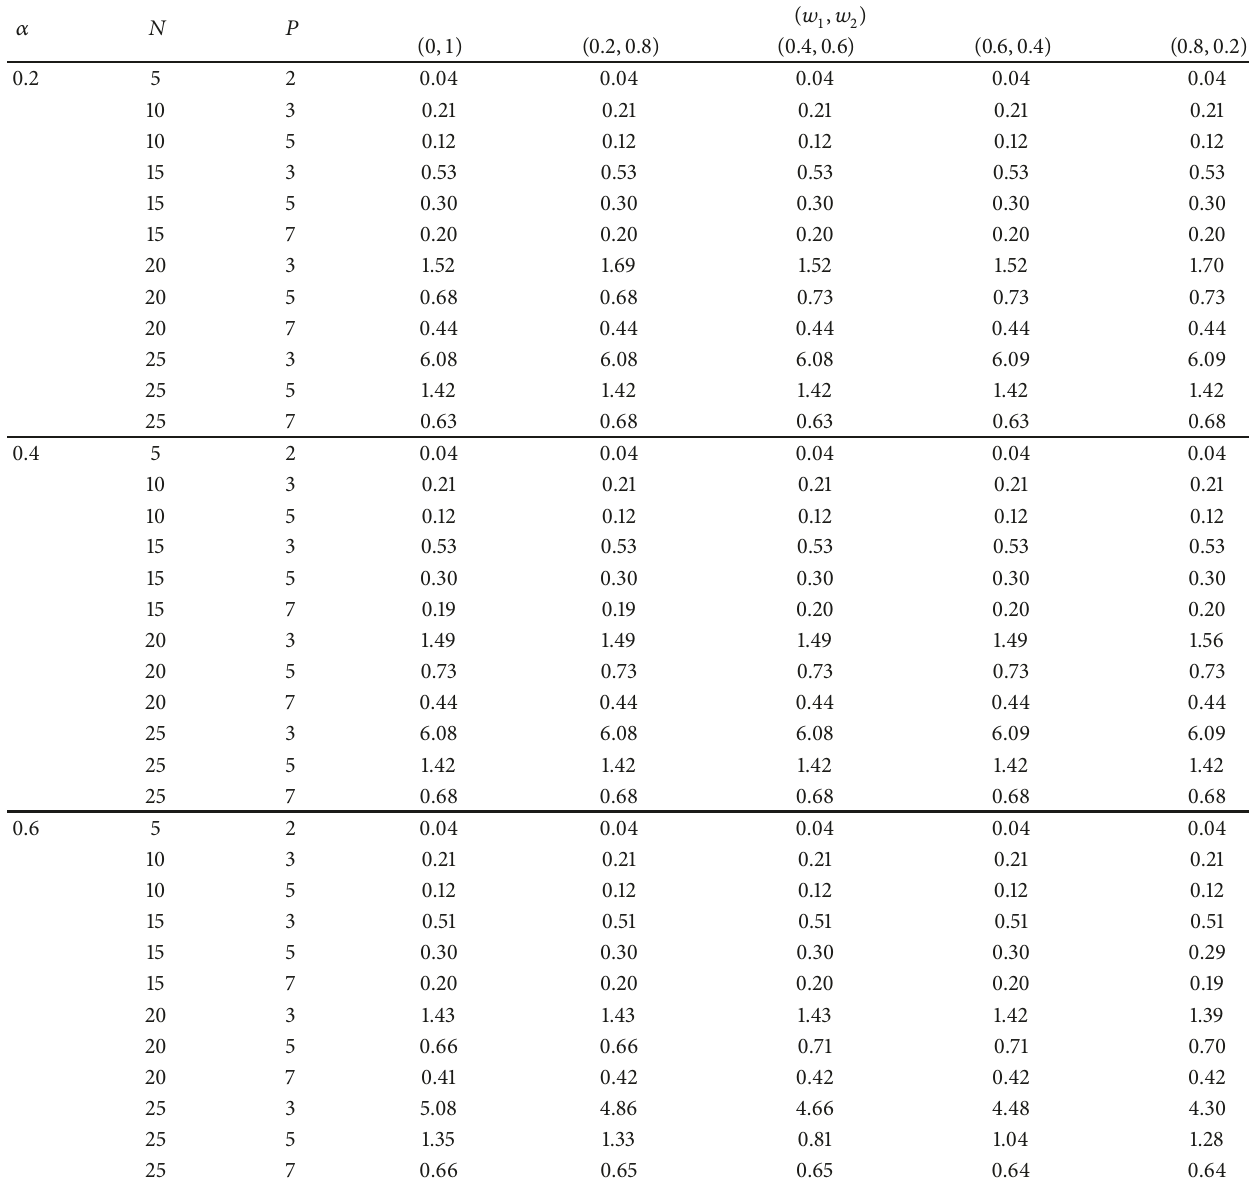
Table 4: Worst-case value